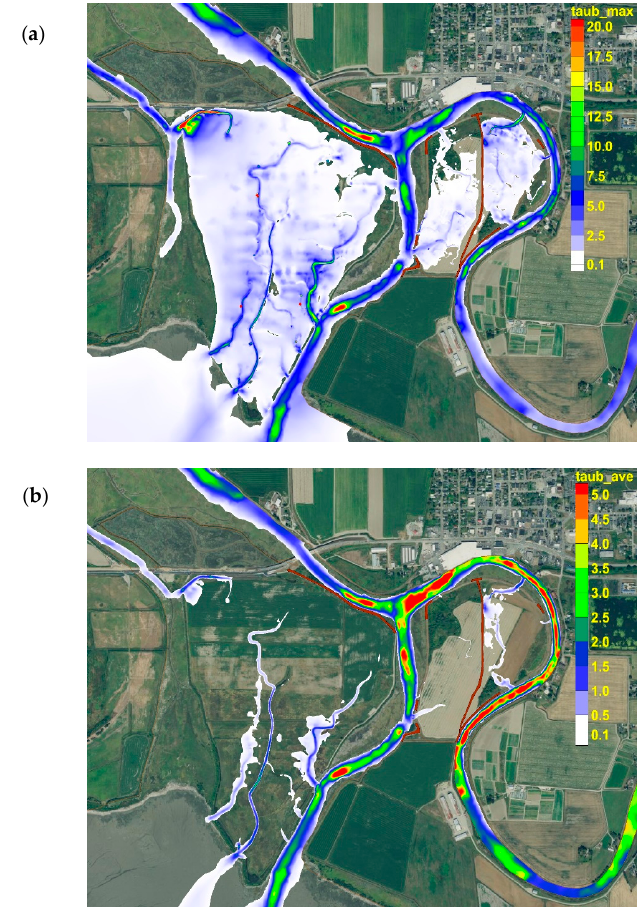
Figure 17. Horizontal distribution of maximum ( a ) and mean bed shear stress ( b ) for the preferred restoration alternative scenario for high-flow (bank-full) conditions at 750.62 m 3 /s.